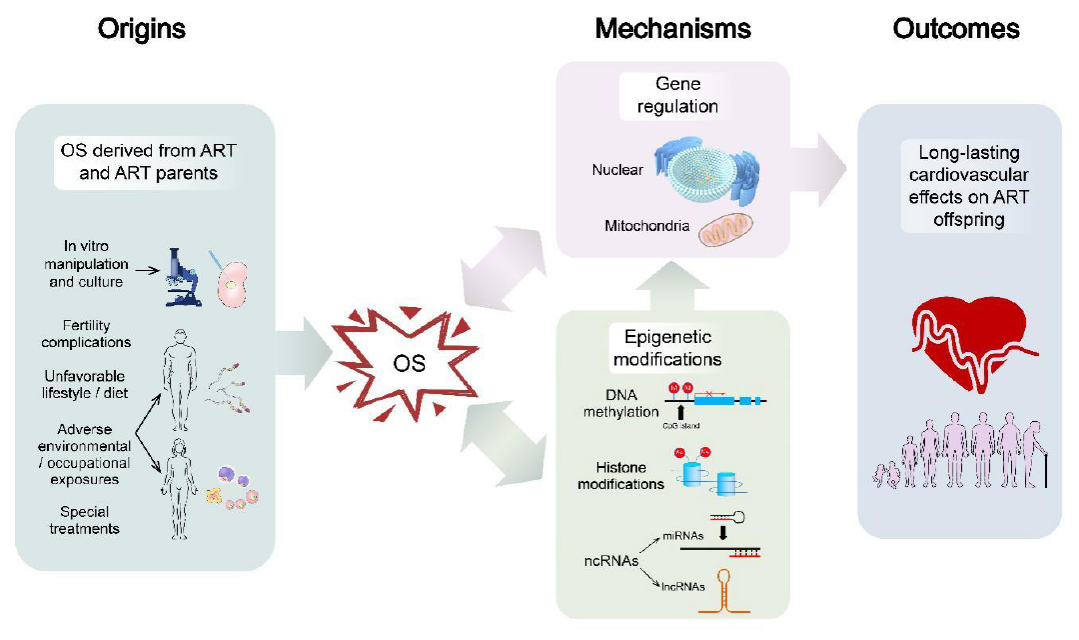
Figure 4. This figure shows the early-life OS exert long-lasting effects on offspring conceived by ART. ncRNAs, non-coding RNAs; miRNAs, micro-RNAs; lncRNAs, long non-coding